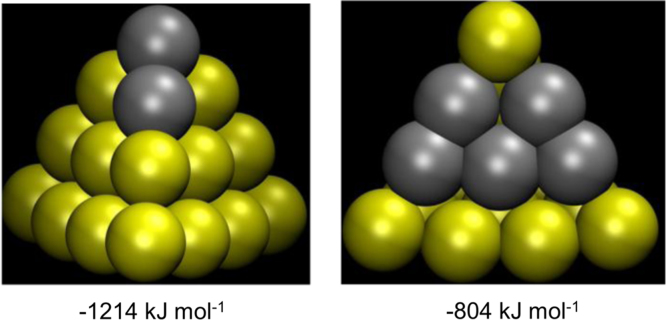
Local-minimum structures and formation energies of Au18Ag2 and Au15Ag5 with maximum number of chemical bonds between silver atoms.